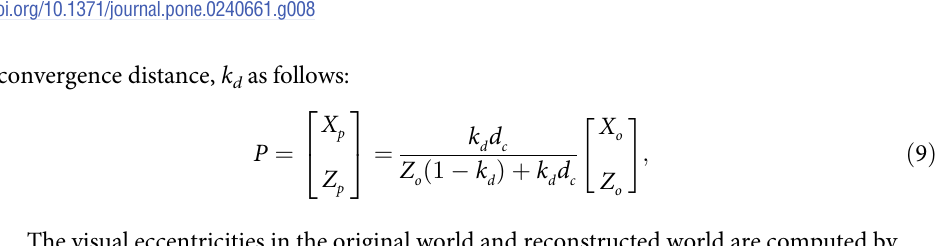
Fig 8. Effect of distance mismatches from the cyclopean eye (i.e., only monocular depth cues). The brown cubes are the simulations in the original world and the blue cubes are the simulations in the reconstructed world. They are identical from the view of the cyclopean